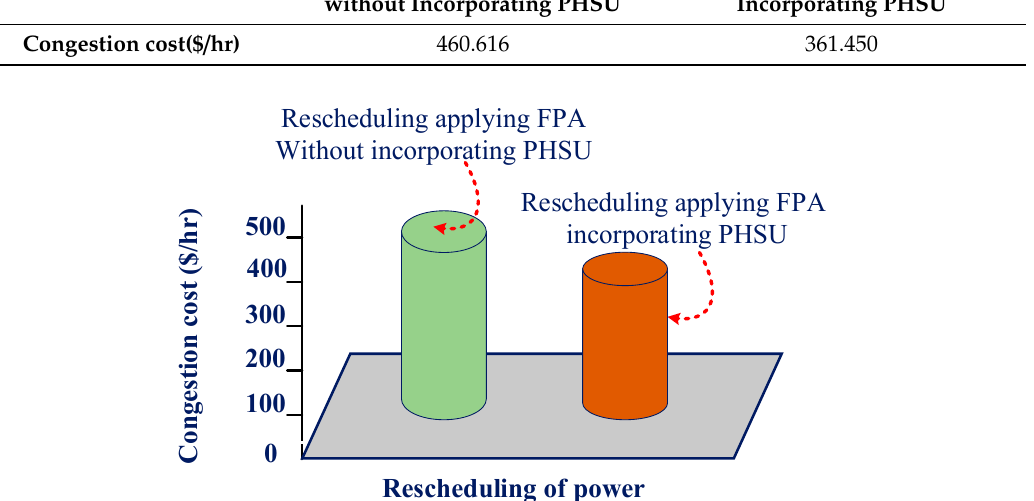
Figure 14. FPA-based cost comparison with and without placement of PHSU for managing congestion. Table 11. FPA-based MVA line flow with and without PHSU.